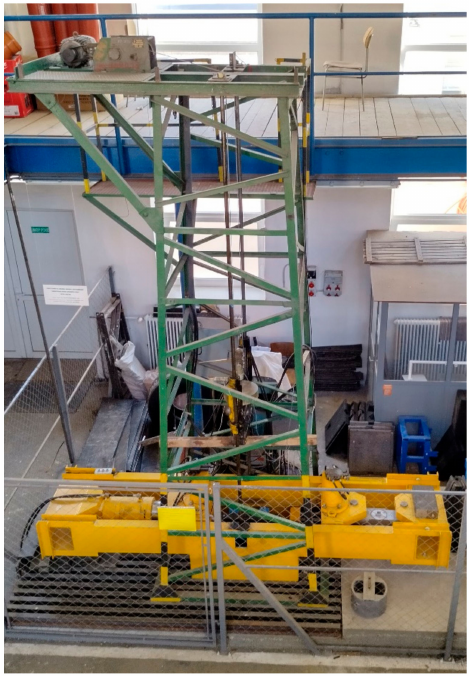
Figure 2. The testing equipment for testing conveyor belts for resistance to